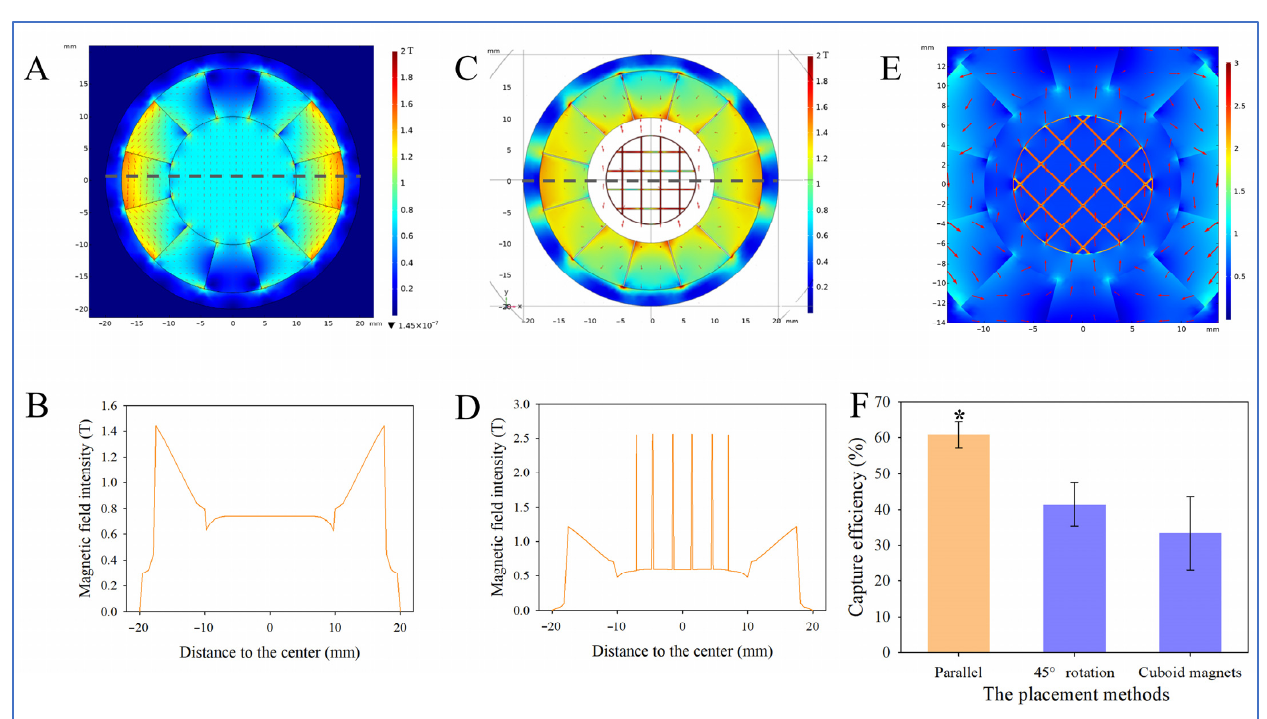
Figure 2. Magnetic field simulation and capture efficiency. ( A ) Simulation of magnetic field intensity within a Halbach cylinder magnet. ( B ) Magnetic field intensity along the horizontal line. Simulation of magnetic field intensity of the iron wire netting inside a Halbach cylinder magnet at parallel ( C ) and at 45 ◦ ( E ) using the placement methods. ( D ) Magnetic field intensity along the horizontal line. ( F ) Capture e ffi ciency of the two placement methods and two cuboid magnets (N = 3). * indicates signi fi cant di ff erence at p < 0.05.